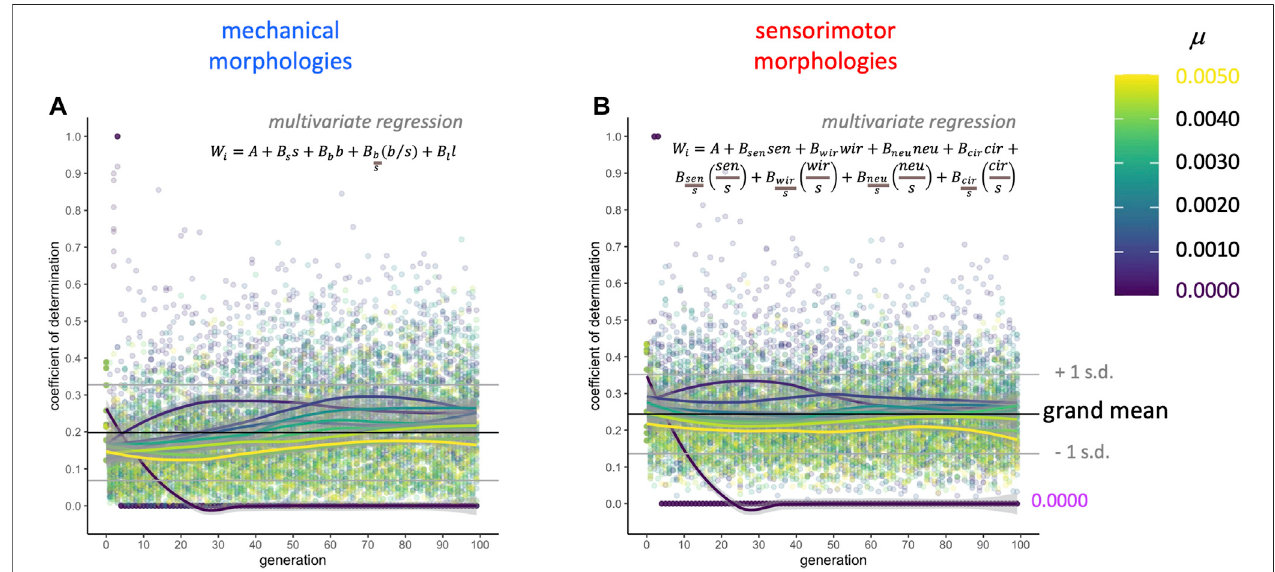
FIGURE 8 | Selection gradient analysis: morphology explains only part of the variance in fi tness. Two multivariate regression models were run on each population (see equations, above) at each level of mutation and each generation: (A) the full set of four mechanical morphologies and (B) the full set of the eight sensorimotor variables.Thefourmechanicalmorphologiesexplainabout20%(grandmean)oftheoverallvariancein fi tnessasmeasuredbythecoef fi cientofdetermination.Theeight sensorimotor morphologies explain about 24% (grand mean) of the variance in fi tness as measured by the coef fi cient of determination.